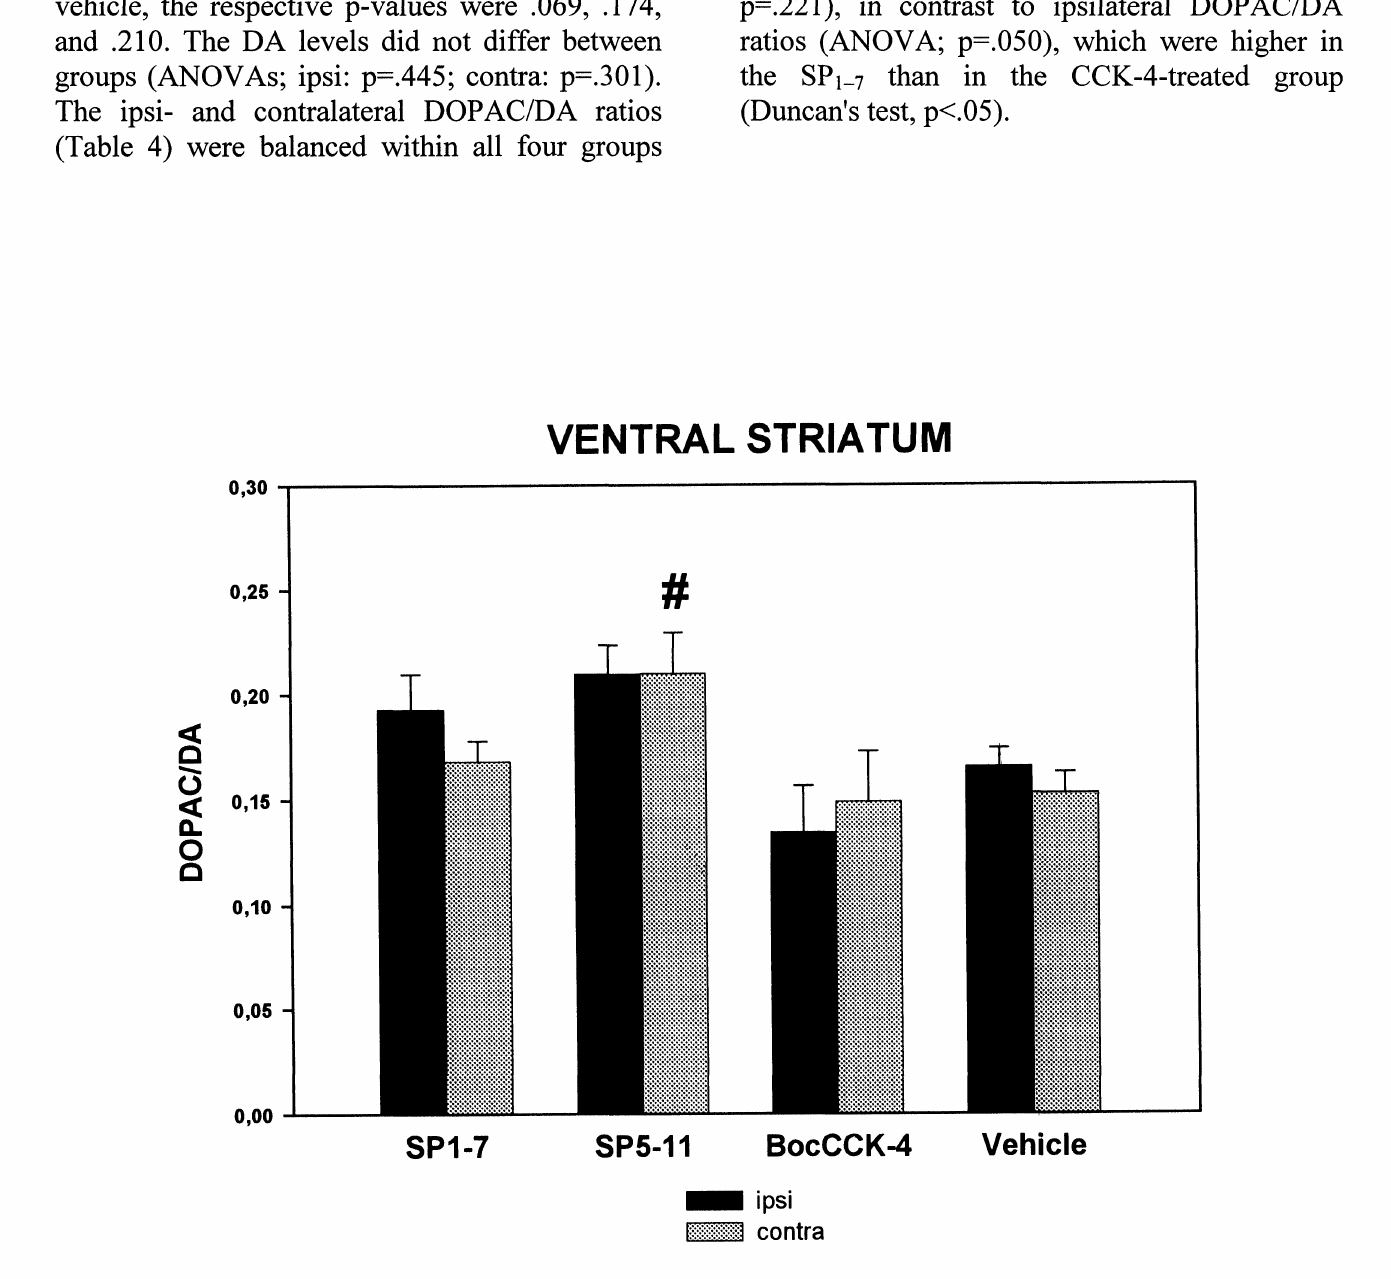
Fig. 2: Ratios of DOPAC/DA (means+SEM) in the ventral striatum ipsi- (full bars) and contralateral (gray the side of 6-OHDA injection. Data were taken from animals with partial neostriatal DA depletions (i.e. neostriatal residual DA levels > 10%). Before the 6-OHDA lesion, the animals had been treated systemically for 8 days, either with SP1-7 (14), SPs-I (n=l 1), CCK-4 (n=9) or with vehicle (n=l 1). Statistical analysis was performed using ANOVAs followed by Duncan’s test" # indicates a difference (p<.05) in comparison with vehicle, and